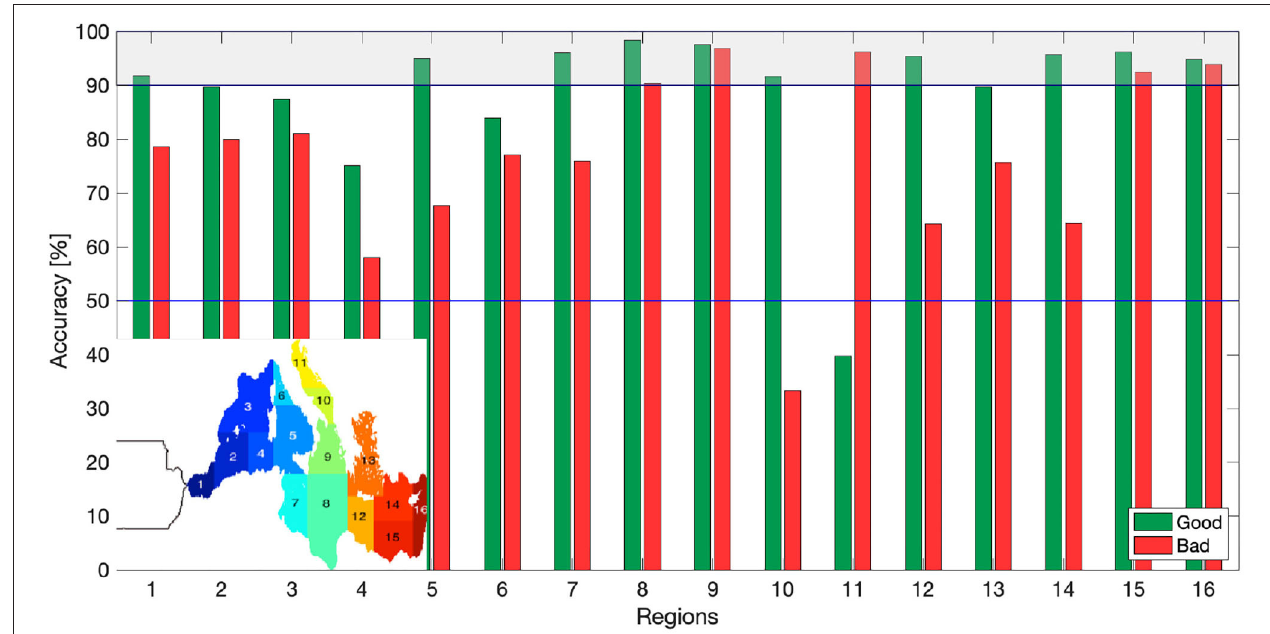
FIGURE 5 | Regional skill assessment. The accuracy for the estimation of the good (green) and the bad (red) samples for 16 Mediterranean